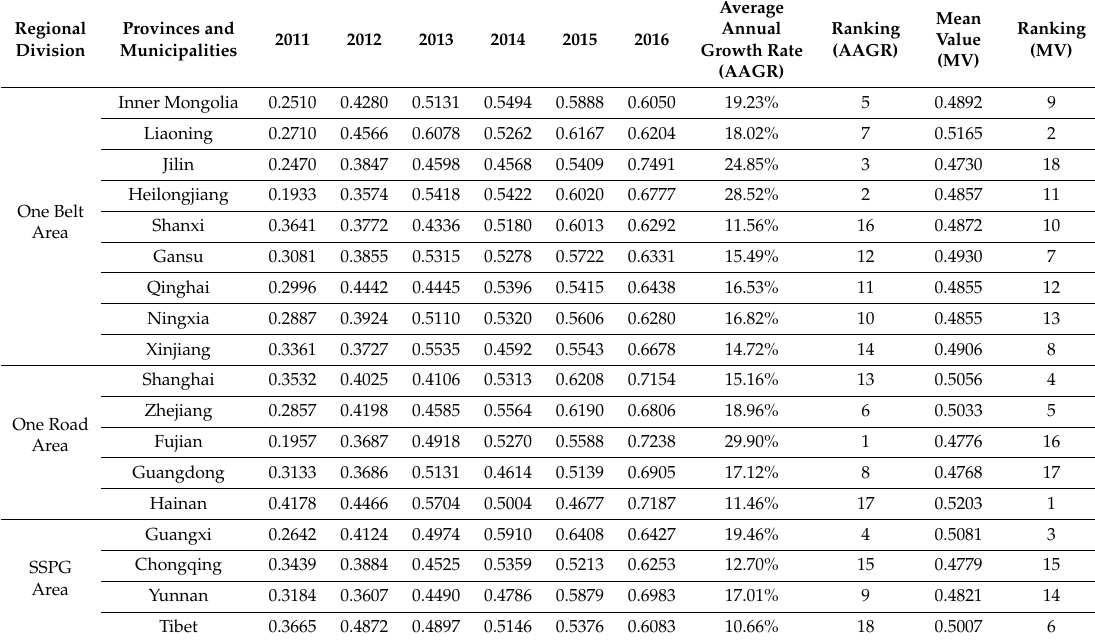
Table 4. The evaluation of water resource security index of China’s "One Belt and One Road" region from 2011 to